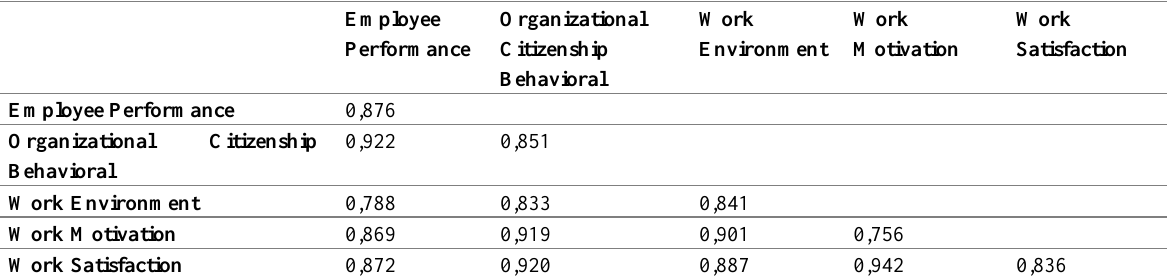
Table 1: Discriminant Validity Test Results